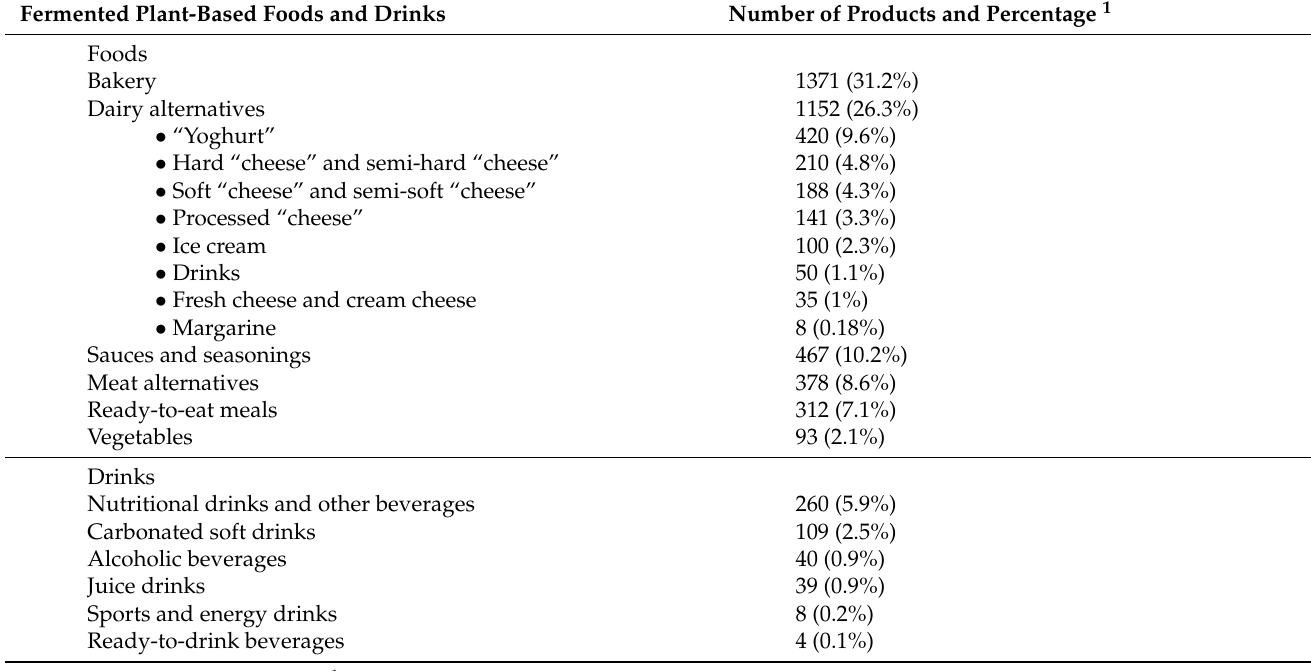
Table 1. Fermented plant-based foods sold in the global market.